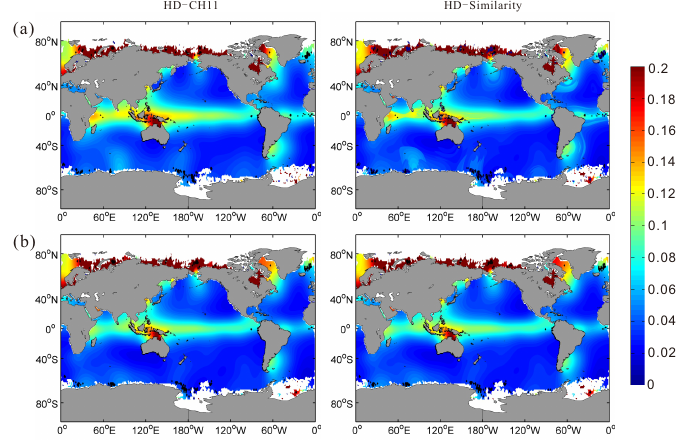
Figure 9. Relative differences between the geographical distributions of ( a ) anticyclonic and ( b ) cyclonic eddies determined using the hybrid and CH11 methods (left column) and using the hybrid and similarity methods (right column) in each 1 ◦ × 1 ◦